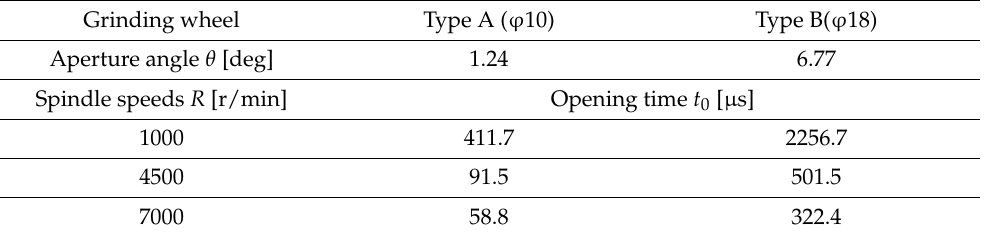
Table 1. Opening time, t 0 , for each grinding wheel and spindle speed.